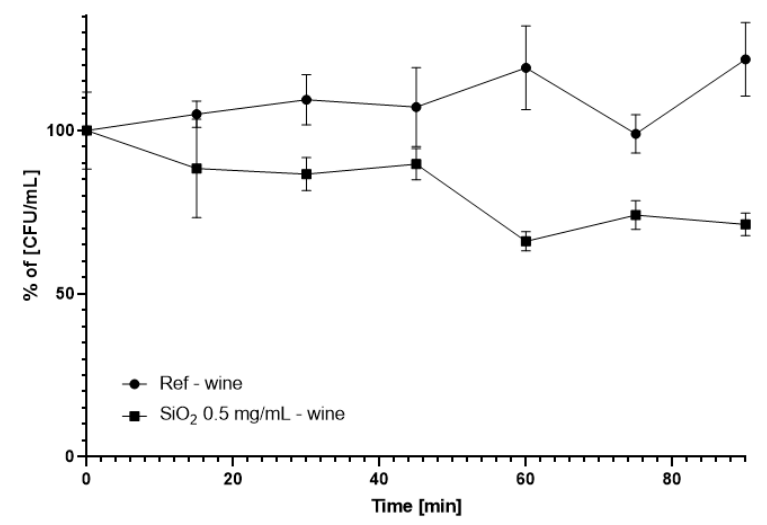
Figure 4. Reduction of the commercial Oenococcus oeni (DSM7008) strain in wine after exposure to the silica nanospheres (SiO 2 ) under continuous stirring.